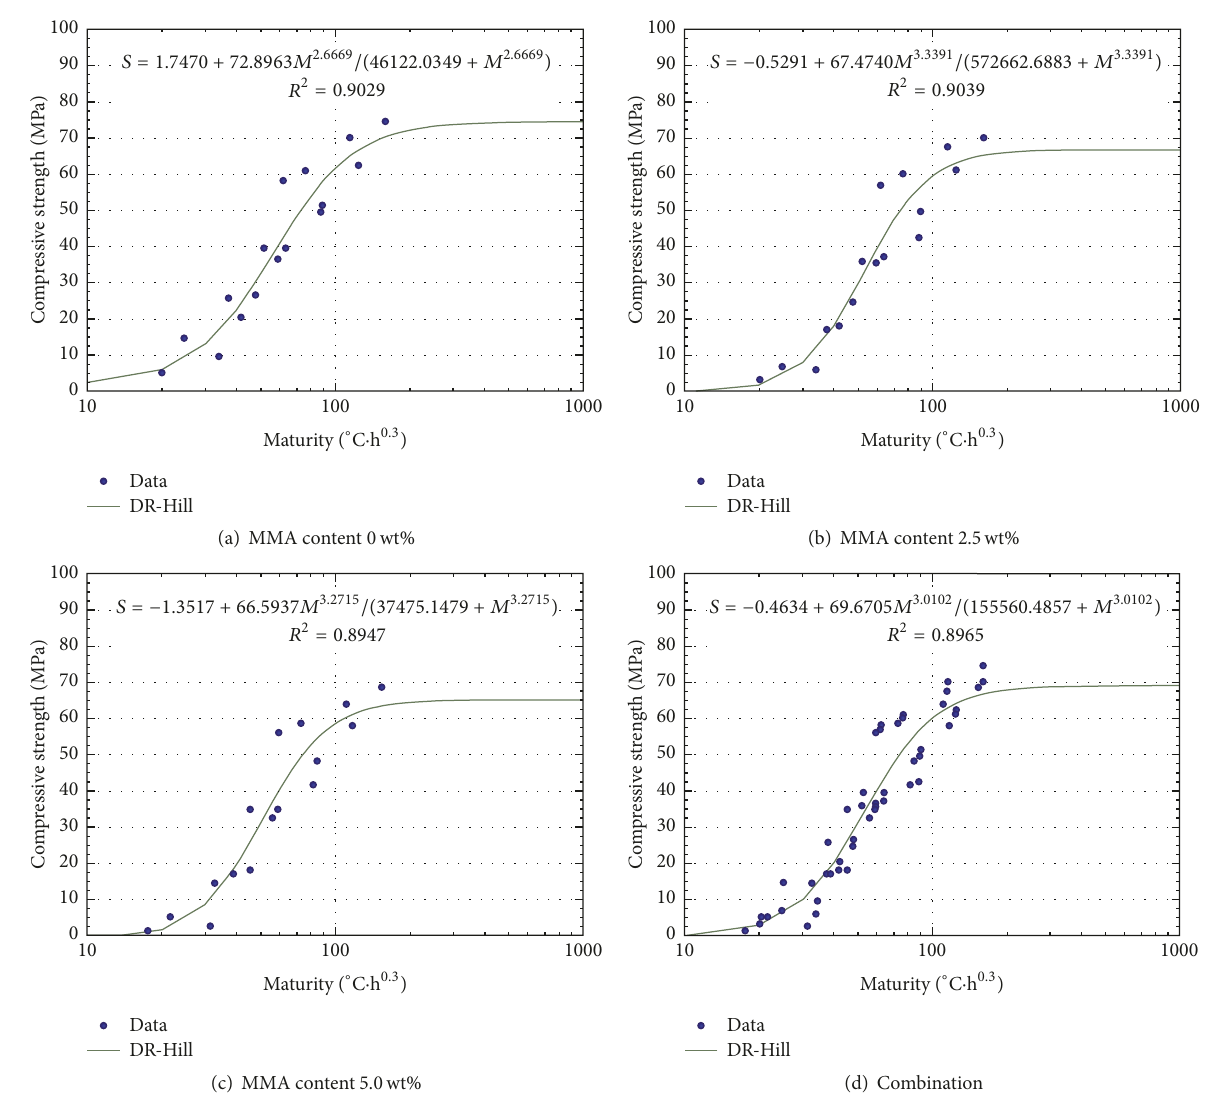
Figure 5: Compressive strength- maturity